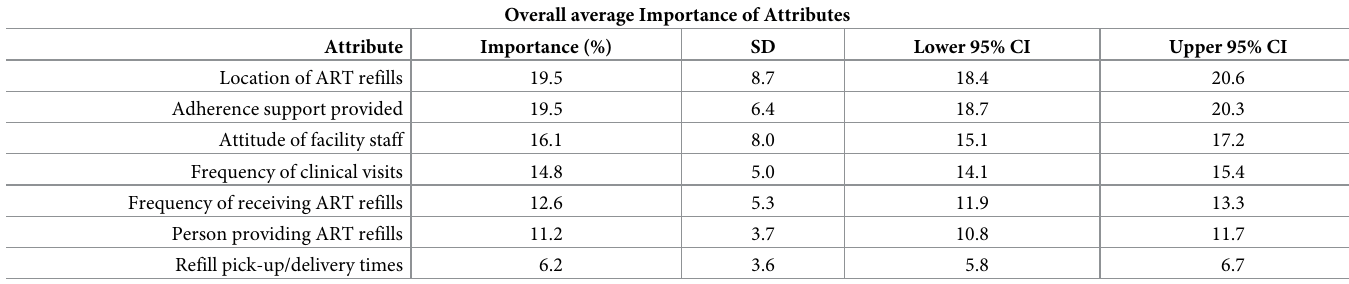
Table 3. Importance of